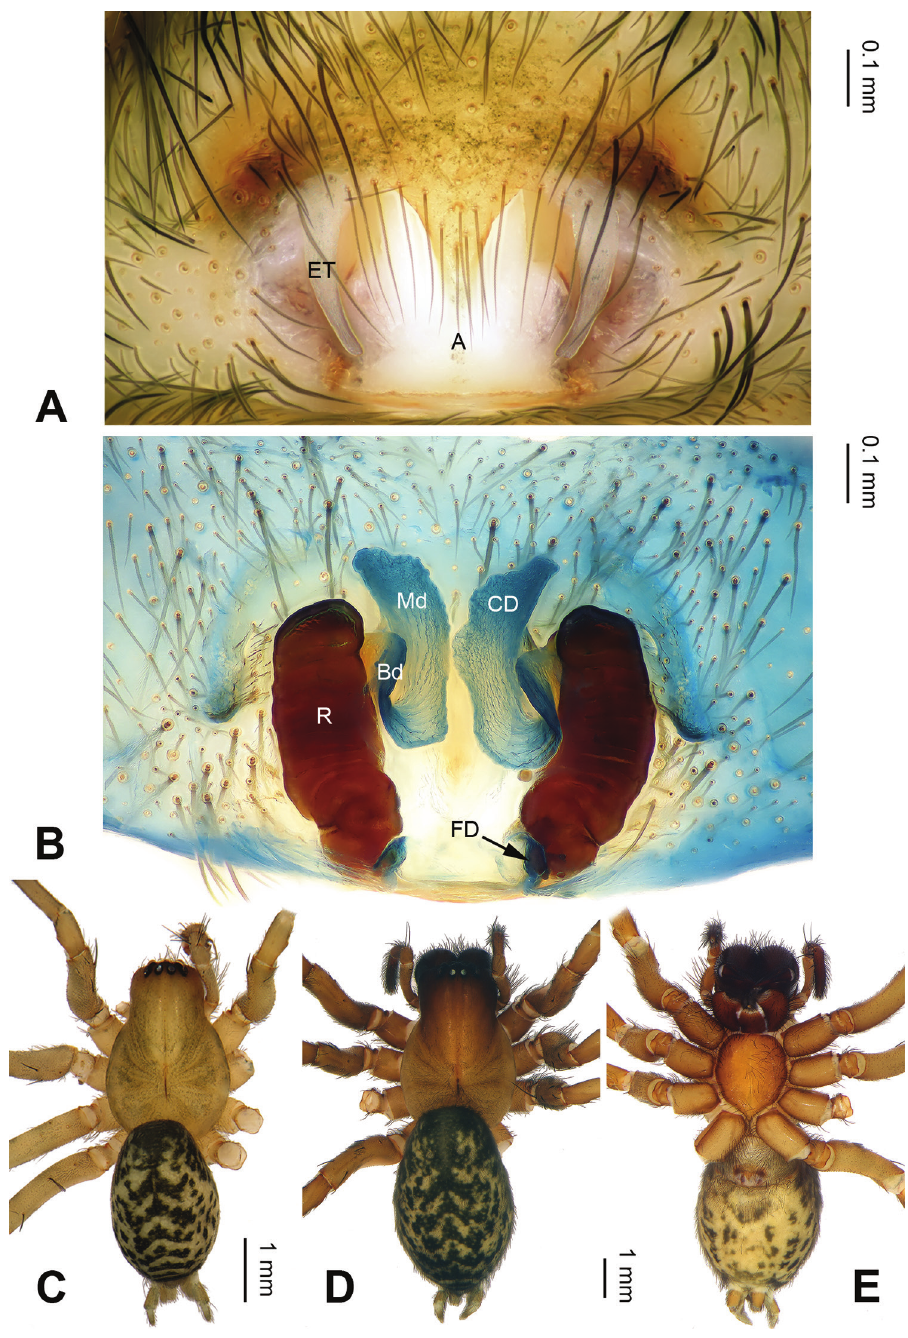
Figure 2. Pireneitega huashanensis sp. n., female paratype and male holotype. A Epigyne, ventral view B Vulva, dorsal view C Male habitus, dorsal view D Female habitus, dorsal view E Female habitus, ventral view. Scale bars: equal for D, E